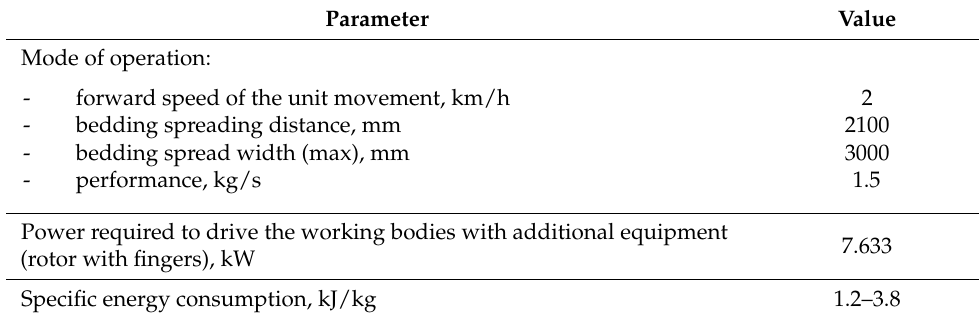
Table 2. Operation modes and experimental research